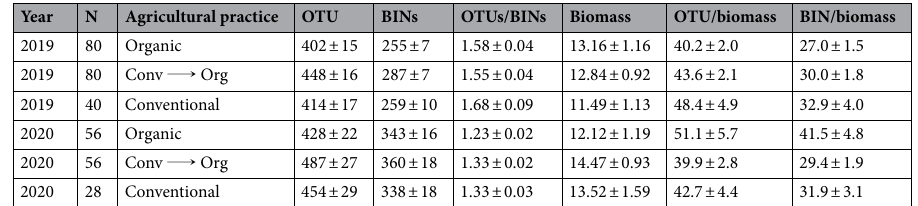
Table 2. Summary data on numbers and relationships of BINs, OTUs, and biomass (in grams). N number of samples. Errors refer to standard errors.